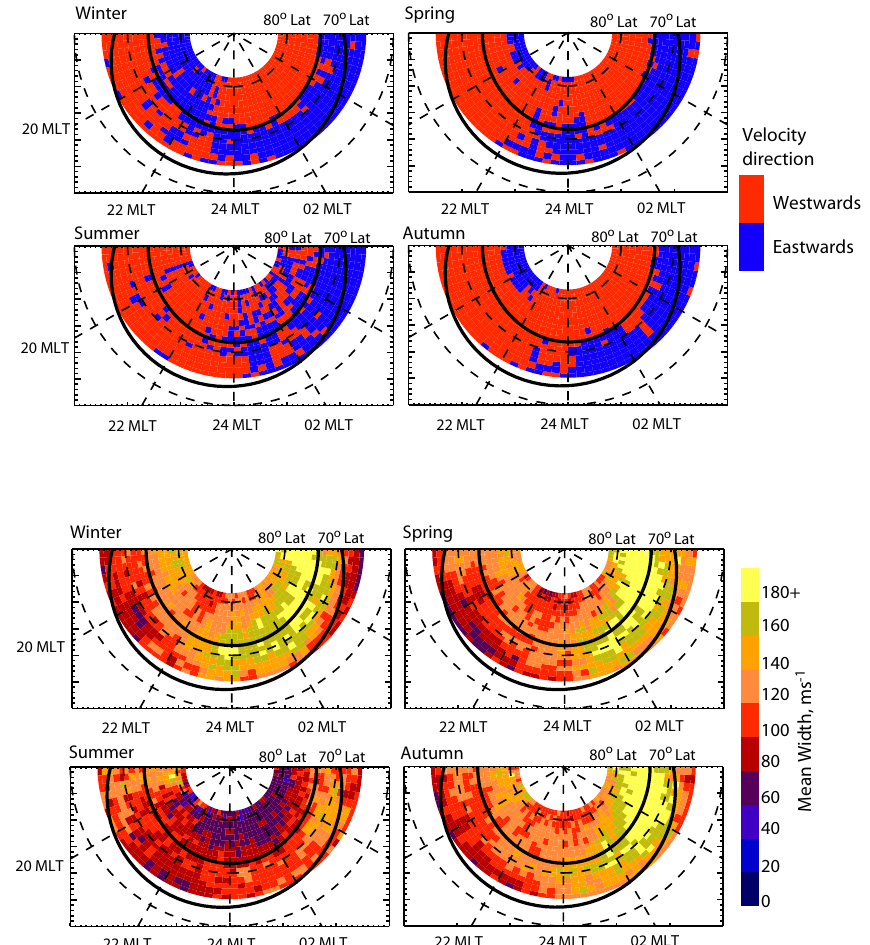
Fig. 8. The top four panels depict the direction of plasma flow observed by the near-azimuthal beams of the Iceland East radar. Red areas show westward moving plasma and blue areas eastward moving plasma. The data are separated into Northern Hemisphere seasons, 15-min MLT intervals and one square for each summary point. A statistical Feldstein auroral oval is overlaid for comparison. The bottom four panels show the similarly separated results for the mean spectral width, again with a statistical oval